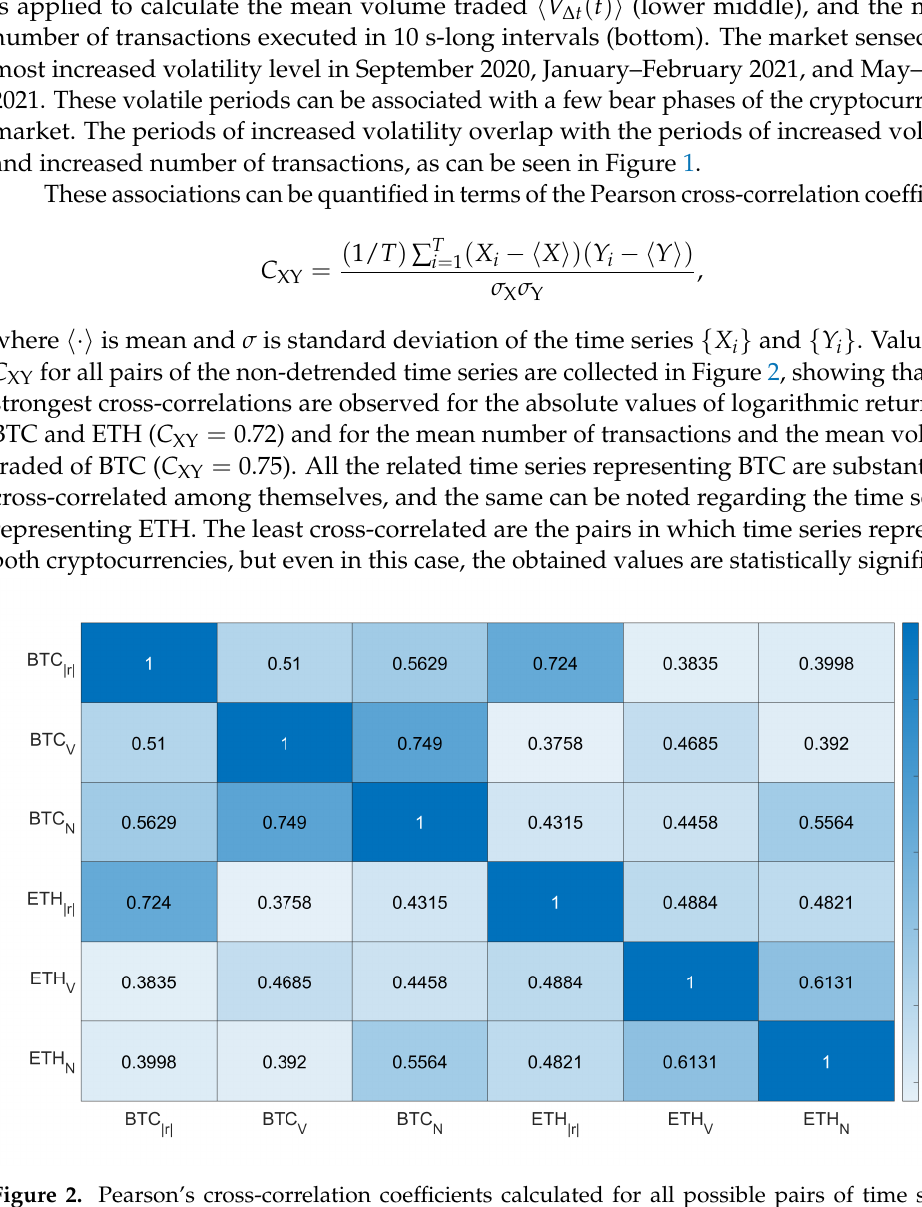
Figure 2. Pearson’s cross-correlation coefficients calculated for all possible pairs of time series considered in this study. All values are statistically